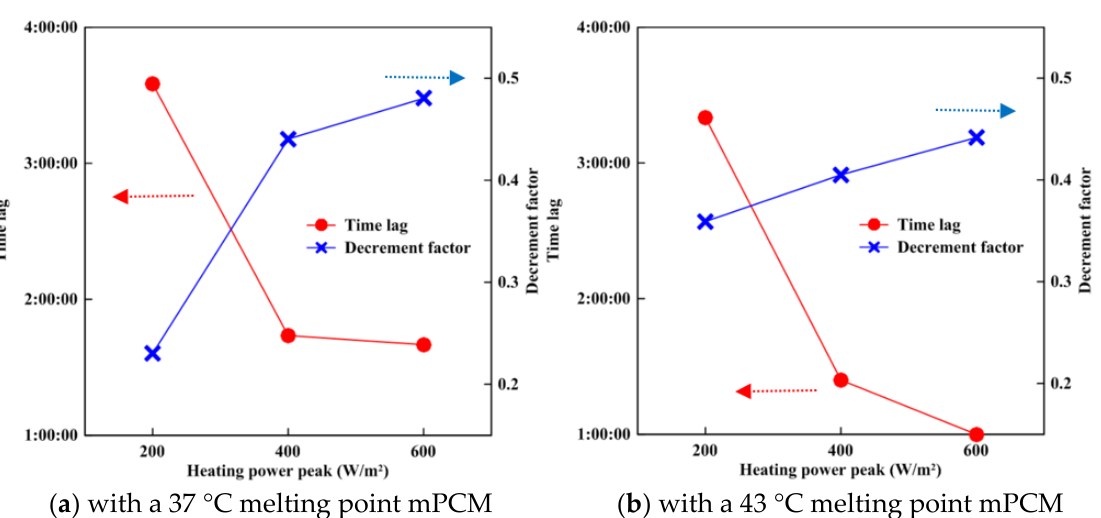
Figure 5. Relationship between the heating power peak and the time lag of the heat flux and decrement factor of the heat flux.